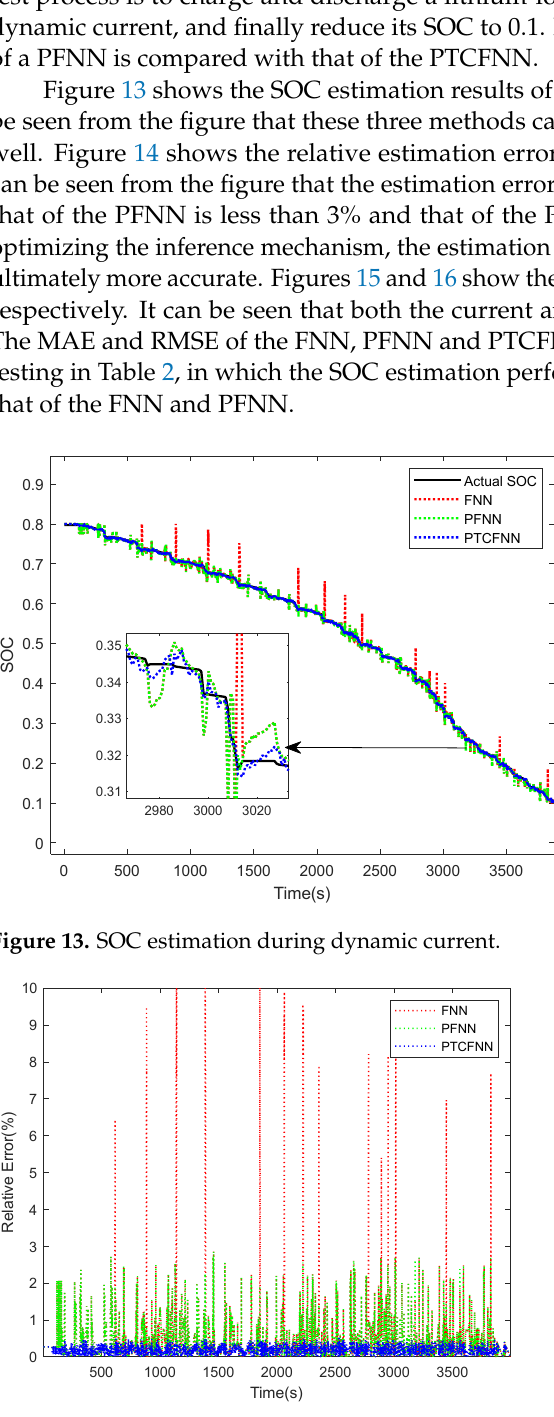
Figure 15. Measured current during dynamic current.